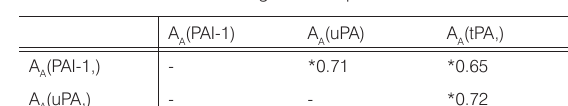
Table 2. Spearman ranked order correlations between the quantita - tive parameters. The data were pooled across the patients. A stands for the area fraction of each fibrinolytic regulator A (PAI-1, uPA, tPA) within the adipose tissue. Autocorrelations and repeating values are replaced by a – sign. Marked (*) correlations are significant at p <0.05.